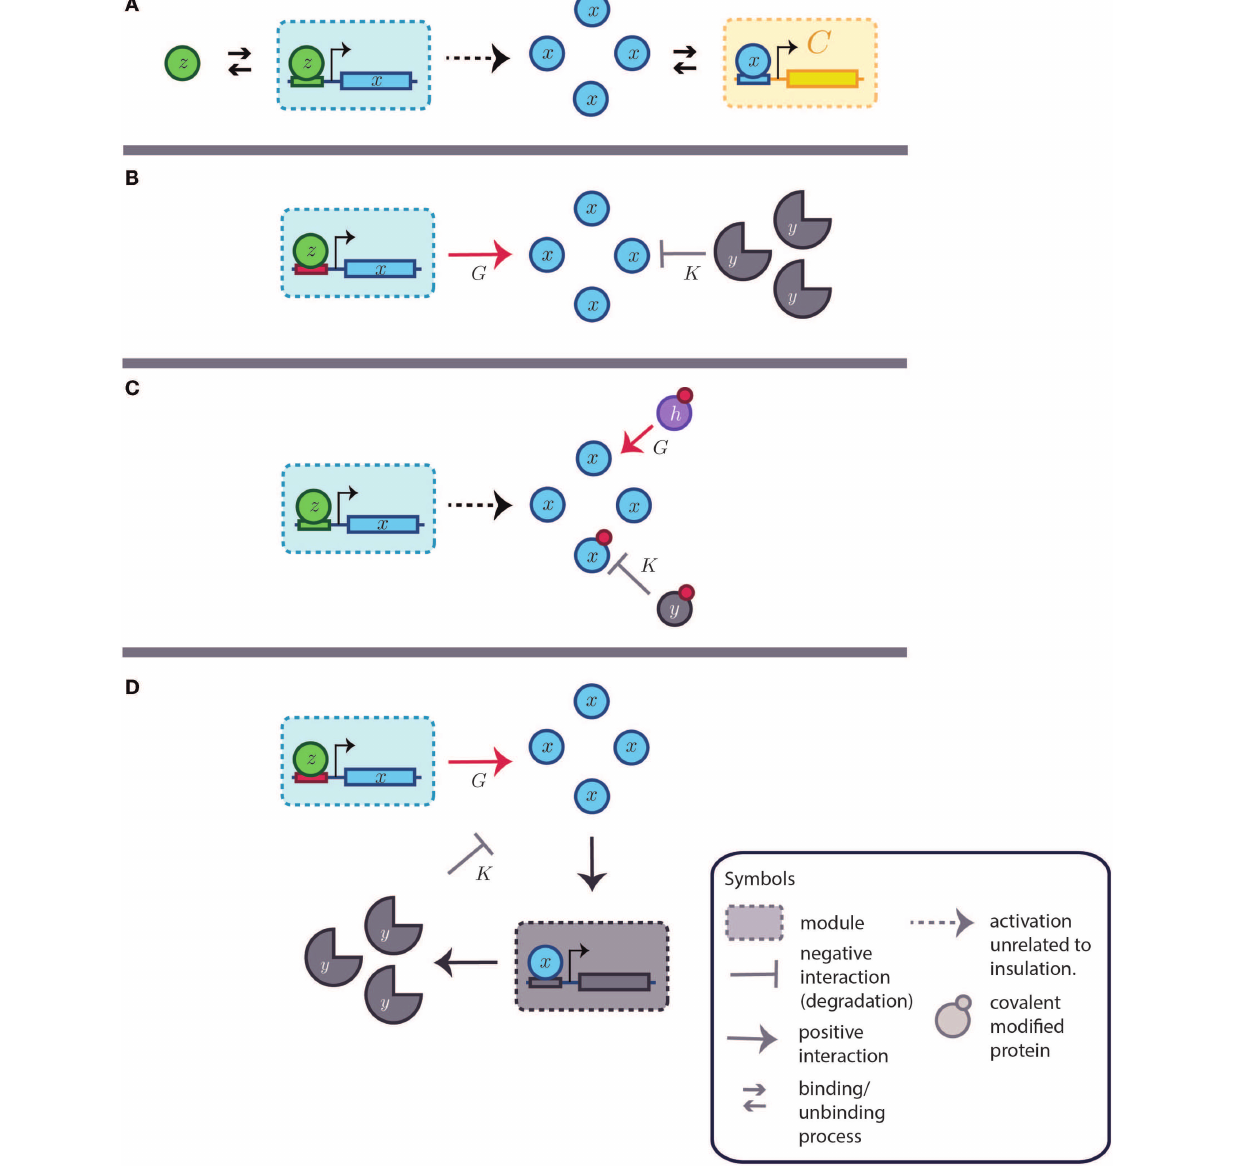
FIGURE 7 | Dynamic insulation schemes based on both gain amplification-degradation and time-scale separation . K and G are the degradation and amplification reactions, respectively. (A) Basic system without insulation. A transcription factor (TF), represented by z , activates the system [partially omitted in (B–D) ]. The small arrows represent binding and unbinding interactions of TFs. The modules are delimited by a square with a dashed perimeter. Downstream to the module and regulated by the module’s output is the module C . The retroactivity to the output of the first module, the one producing x , depends on the association and dissociation rates as well as in the amount of binding sites present in module C . Other parameters, as the TF–DNA complex degradation rate also influences the retroactivity value and its effects